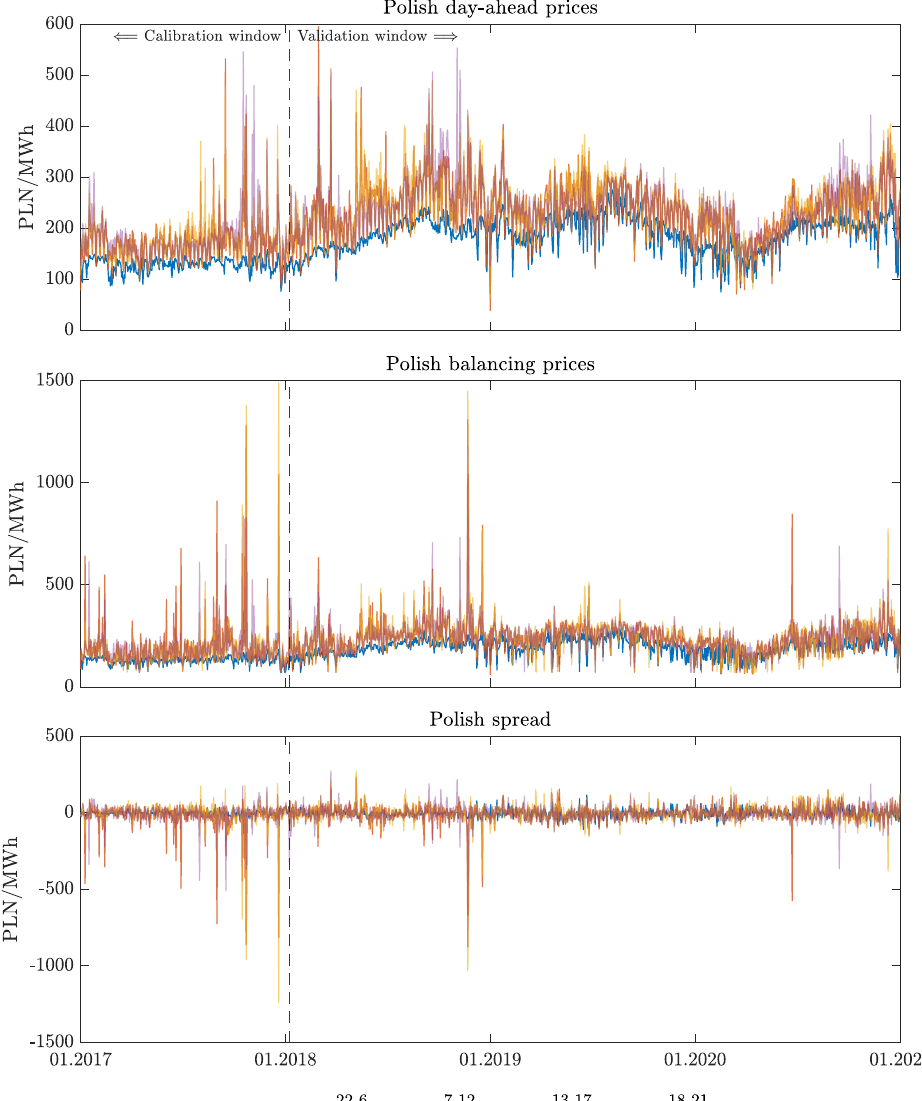
Figure 2. Polish day-ahead prices ( top panel), balancing prices ( middle panel) and the spread, i.e., the difference between day-ahead and balancing prices ( bottom panel). For illustration the hourly prices were averaged over four representatives blocks of hours: 22–6 (night), 7–12 (morning peak), 13–17 (midday), 18–21 (evening peak). Source: Authors’